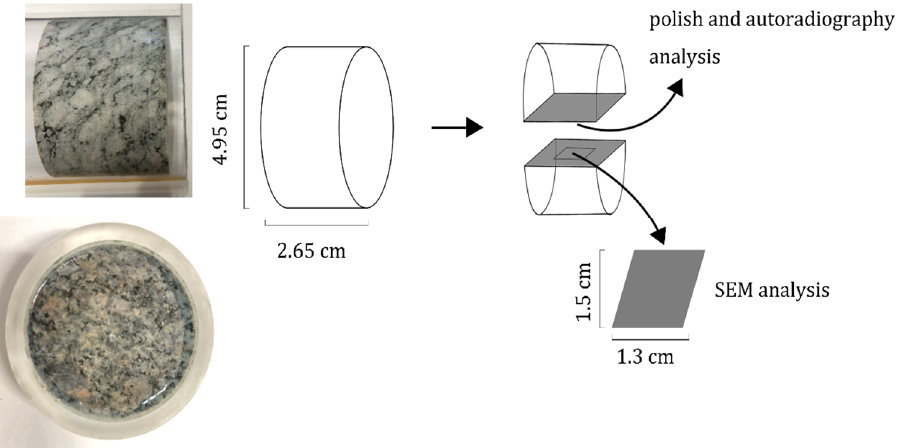
Figure 1. Left: Grimsel granodiorite rock core that was sealed in a cylinder for the electromigration device (Left). The same sample was impregnated with C-14-PMMA for autoradiography. Right: The sample sawing procedures and the surfaces for autoradiography and SEM/EDS analysis. Table 1. Mineralogy analysis of Grimsel granodiorite by using the XRD (wt.%) and polarizing microscopy (point-counting by 500 points, vol.%) performed in the Geological Survey of Finland. Minerals XRD (wt.%) Thin Section Analysis (vol.%)